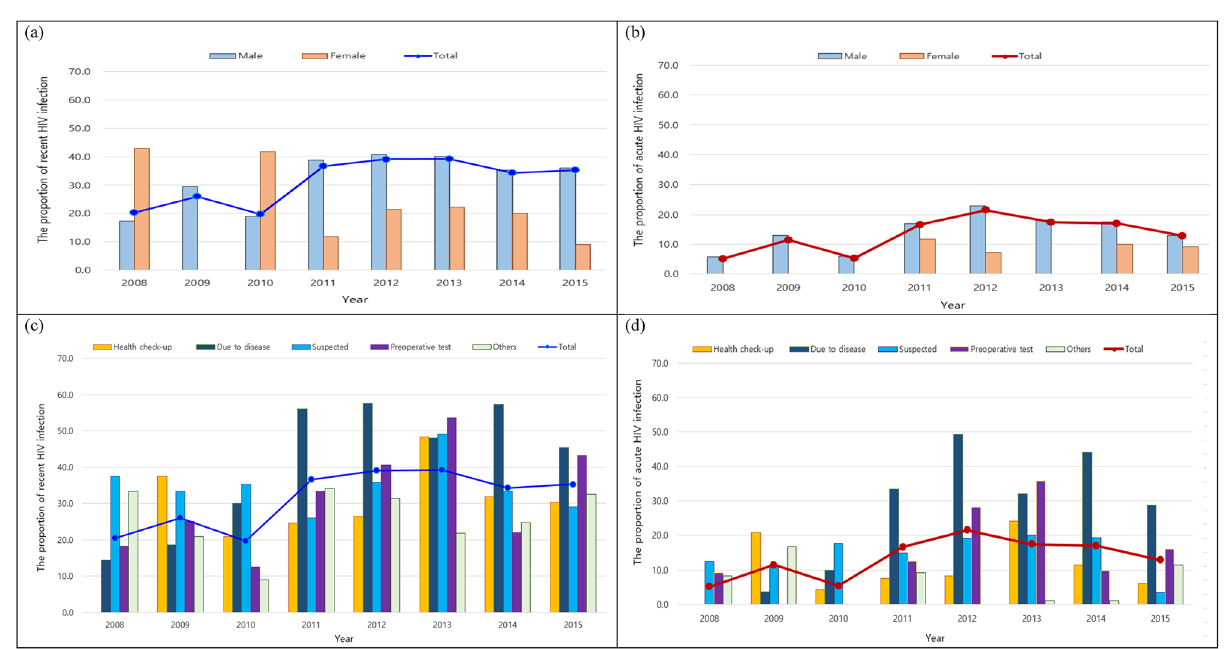
Figure 3. Comparison of recent and acute HIV infection rates by gender, reason for HIV testing under 30 years of age. ( a ) Recent HIV infection rate under 30 age group by gender. ( b ) Acute HIV infection rate under 30 age group by gender. ( c ) Recent HIV infection rate under 30 age group by reason for HIV testing. ( d ) Acute HIV infection rate under 30 age group by reason for HIV